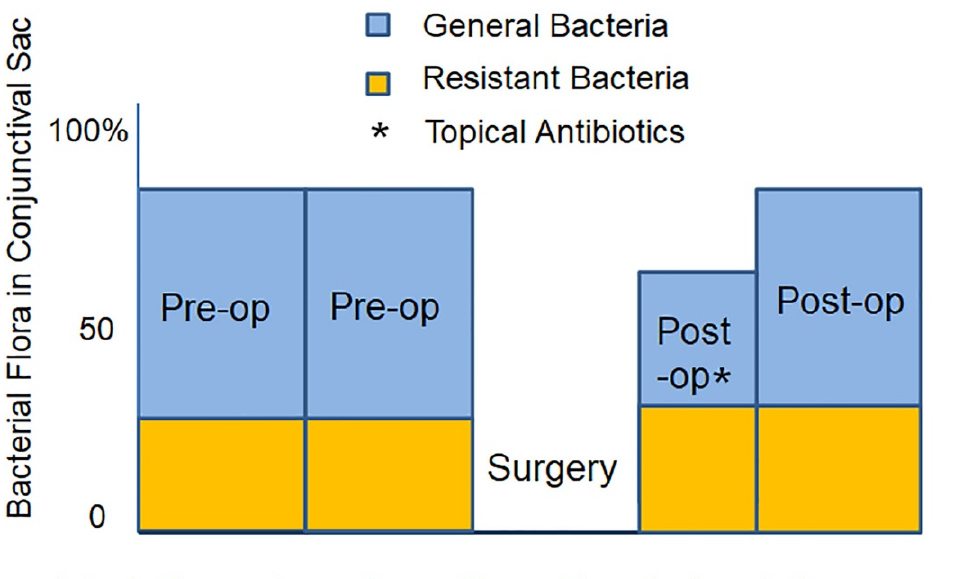
Figure 2. Discontinuing preoperative antibiotic eye drops, performing intraoperative povidone-iodine irrigation and shortening the period of postoperative antibiotic eye drops. By attempting to render the ocular surface microbe-free by irrigation with povidone-iodine, the risk of bacteria entering the eye is reduced. By stopping preoperative use of antibiotic eye drops and shortening the period of using postoperative antibiotic eye drops, the increase in resistant bacteria is suppressed. (Authors’ unpublished images).